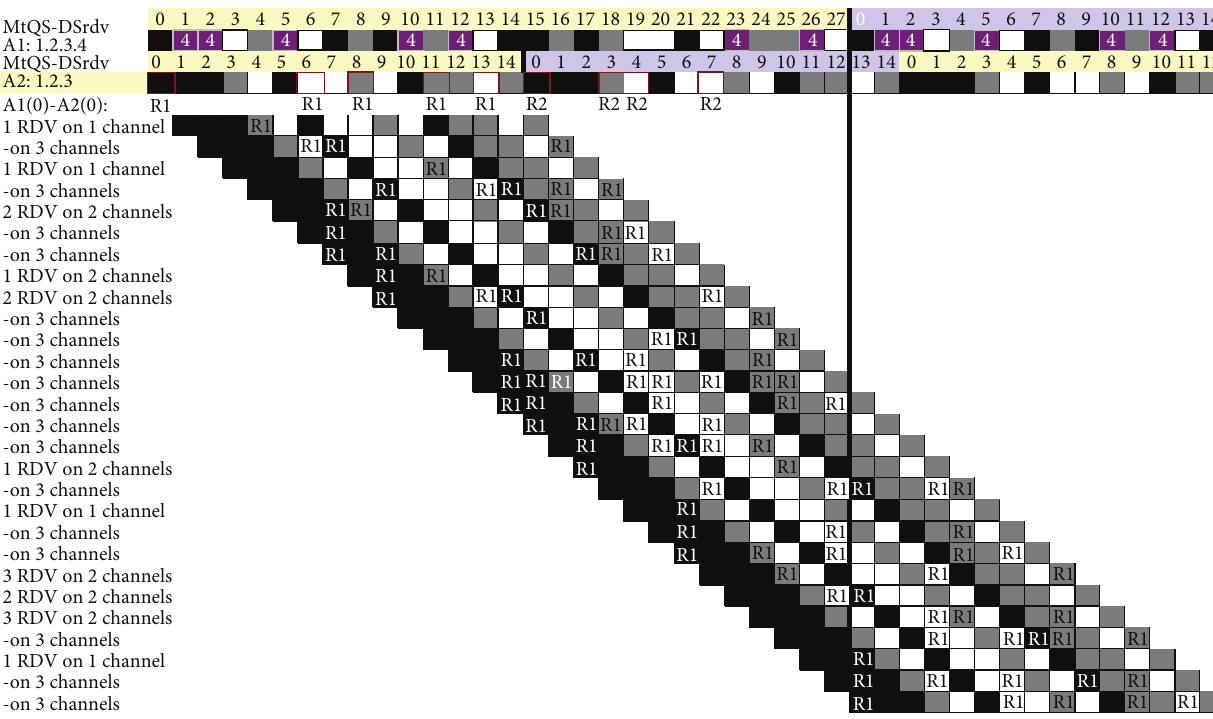
Figure 7: Asymmetric channel view: combination of maps with 3 and 4 channels, while rotating the cycle; RDV consideration in Θ ; black square stands for channel 1, gray square for channel 2, and white square for channel 3; R stands for Rendezvous.